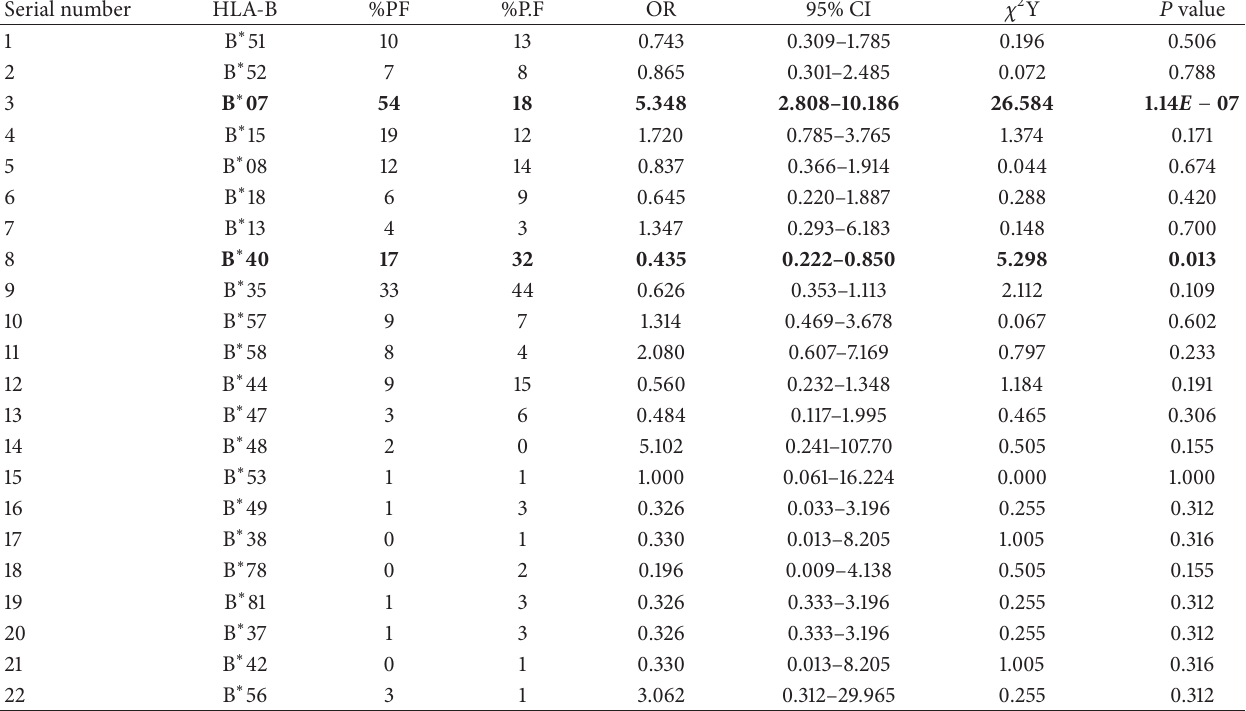
Table 1: Distribution of HLA-B alleles among B27 negative SpA patients and controls from Western India (patients ( 𝑛 = 100 ); controls ( 𝑛 = 100